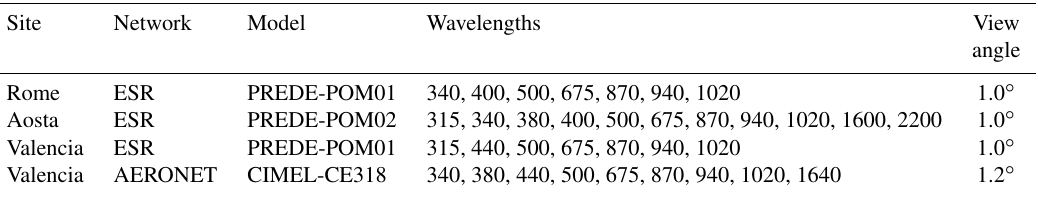
Table 1. Characteristics of the sun–sky radiometers located at the three sites. The exact wavelengths of the CIMEL at Valencia can slightly change depending on particular instrument